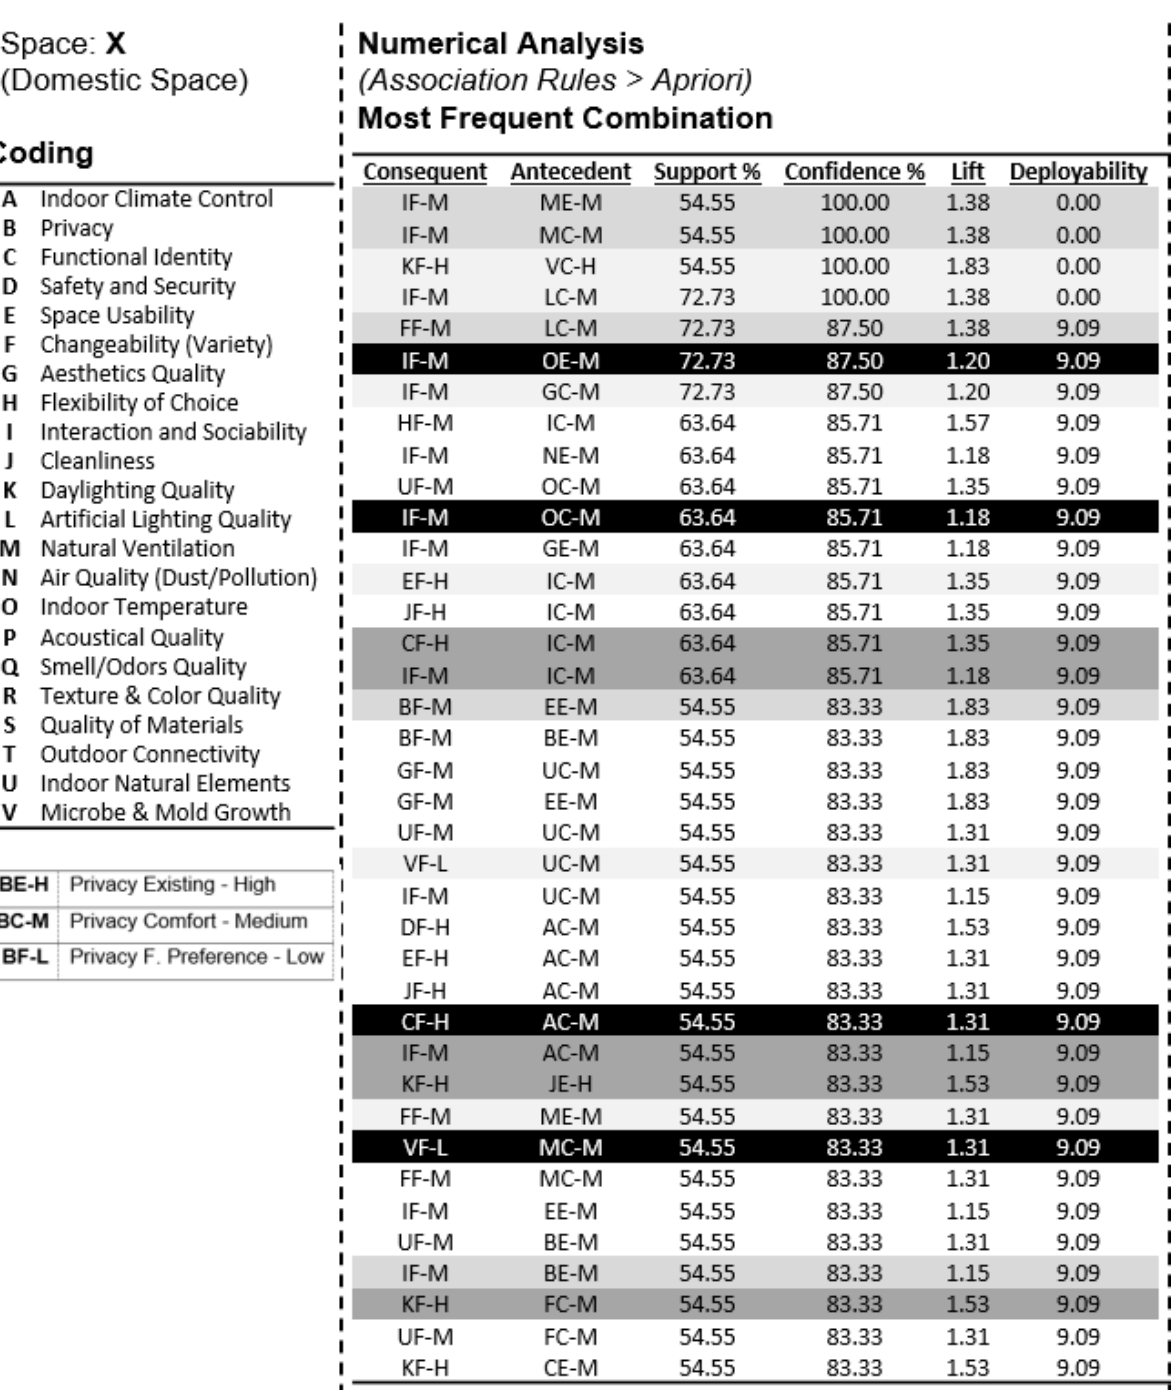
Figure 10. Numerical correlation (association) of spatial and environmental design factors. (Source: author; based on analysis). author; based on